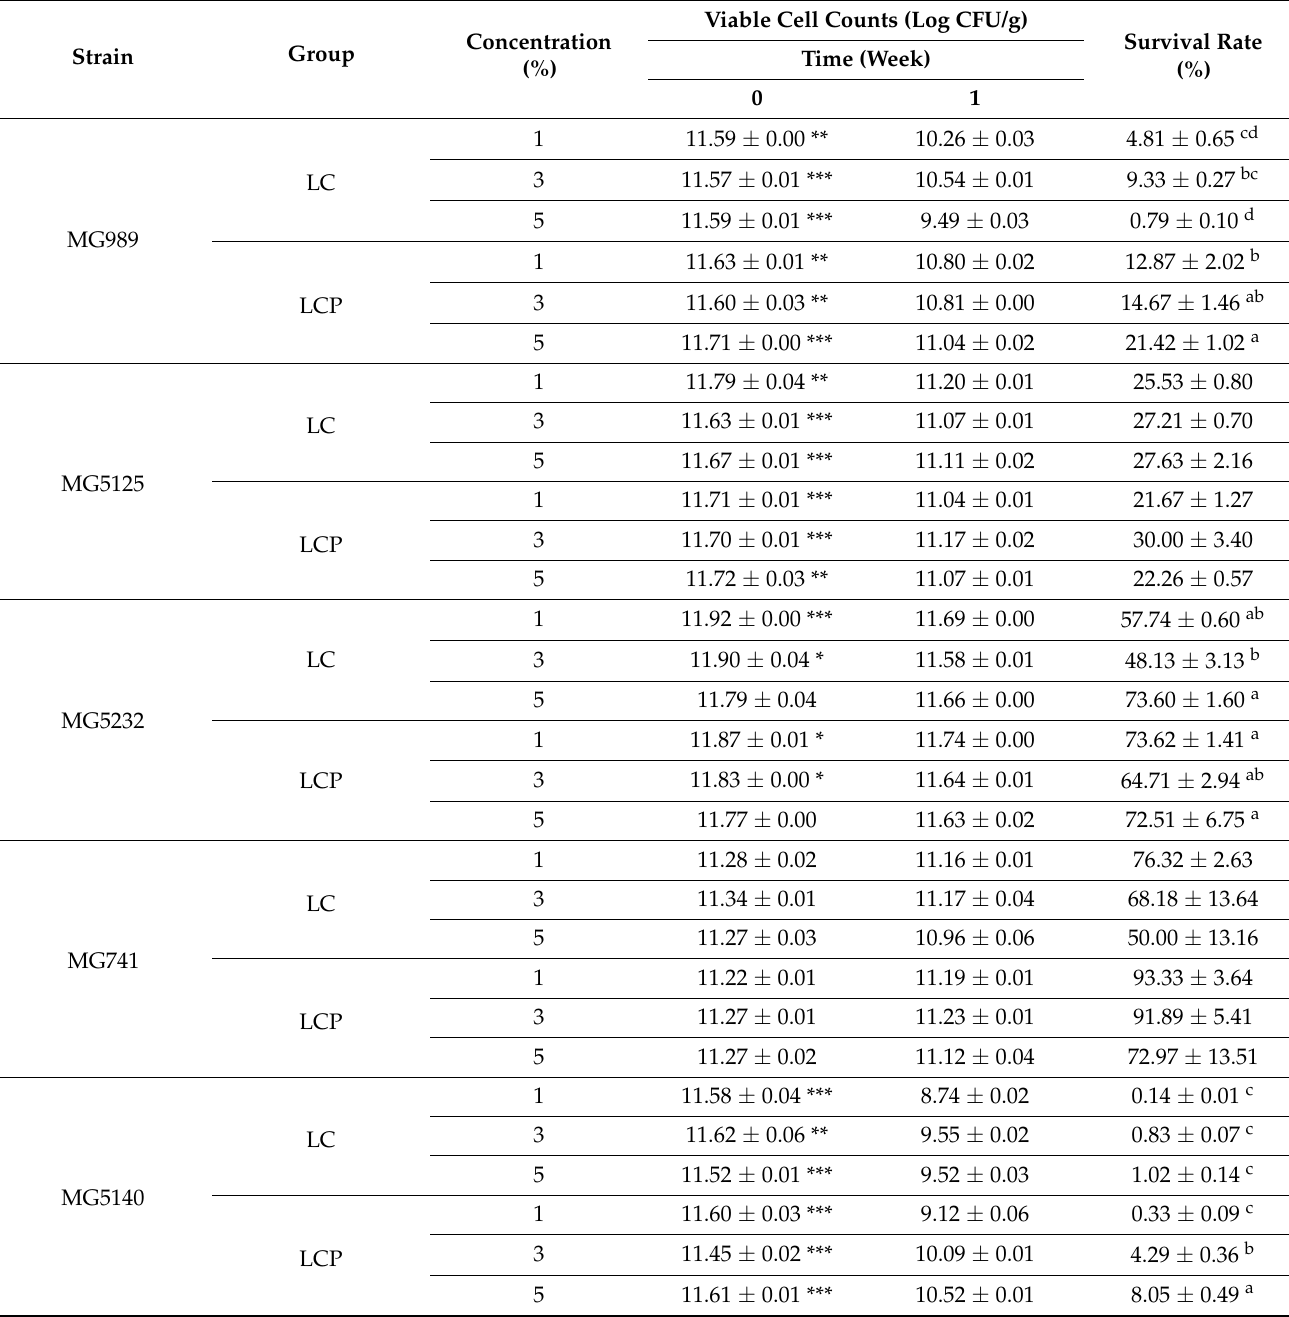
Table 1. Changes in the survival rate of LAB strains by treatment with different concentrations of low molecular weight collagen and collagen-peptide for 1 week in the accelerated stability